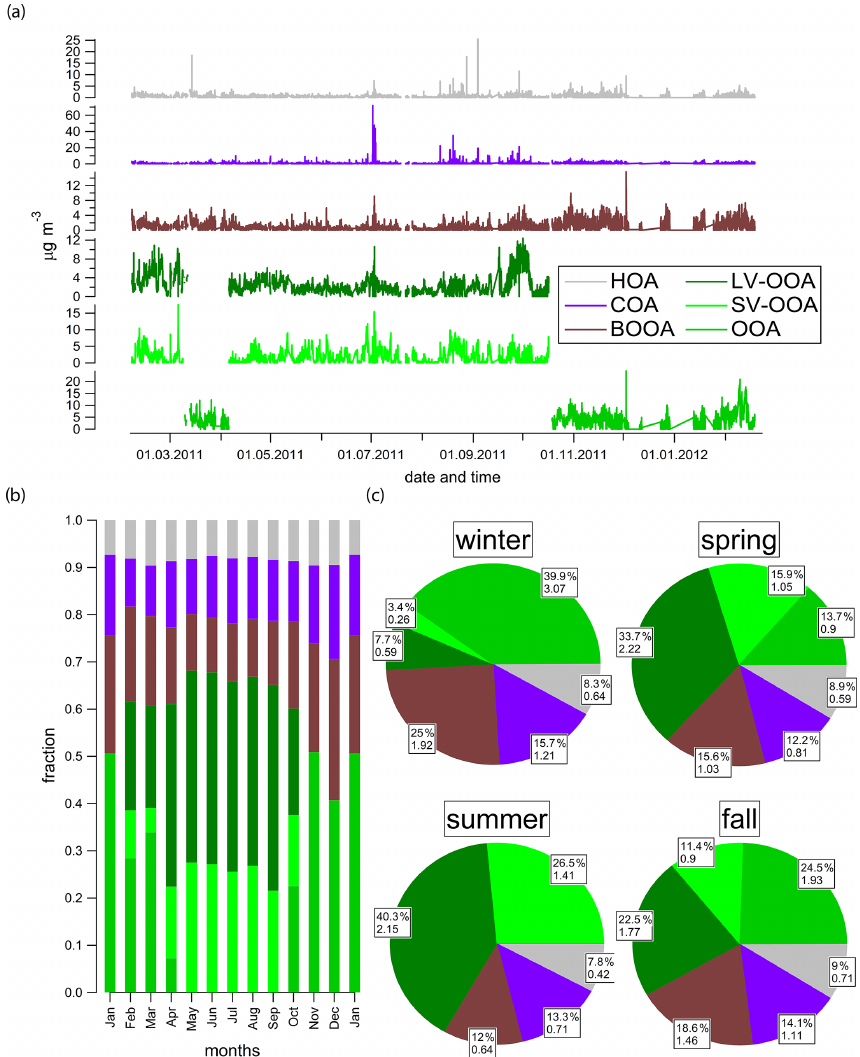
Figure 3. (a) 30min average concentrations, (b) relative contributions and (c) pie charts for the calendar seasons of the sources between February 2011 and February 2012. Gaps in the data represent interruptions due to maintenance and/or technical problems of the ACSM during the last third of the campaign, mostly due to clogging of the ACSM inlet orifice. The lower values in the pie charts are the seasonal mean contributions in µgm − 3 . Note that the OOA factors are represented either as LV-OOA and SV-OOA (five-factor solution) or OOA alone (four-factor